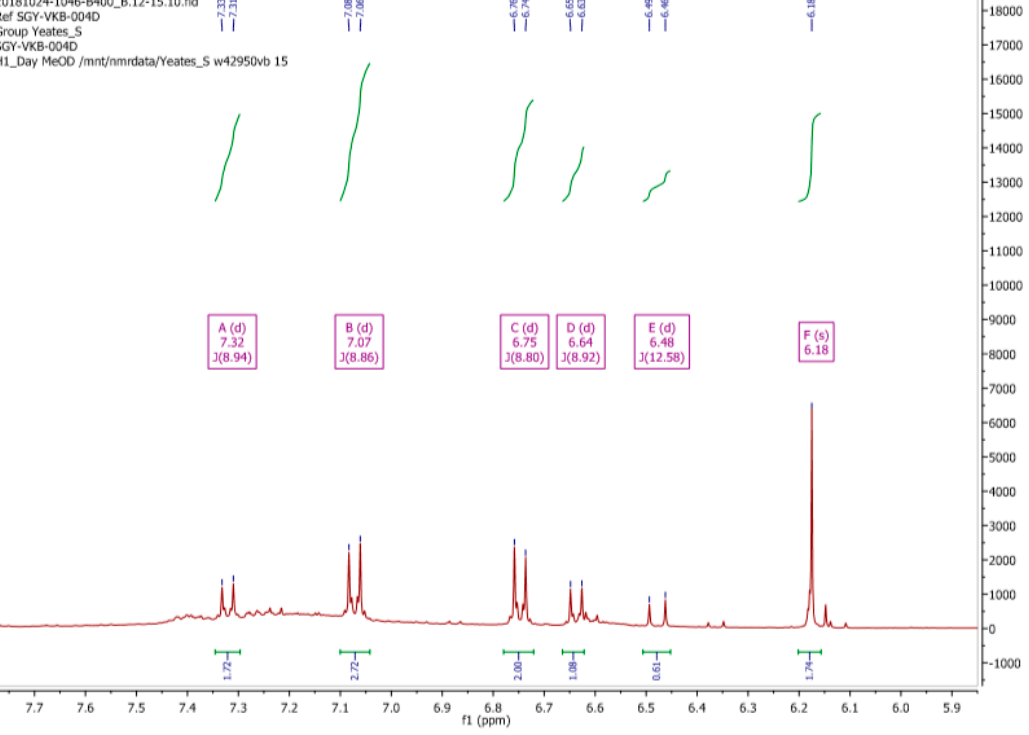
Figure 6. 1 H-NMR spectrum of the product from attempted preparation of ( 1 ) in CD 3 OD.